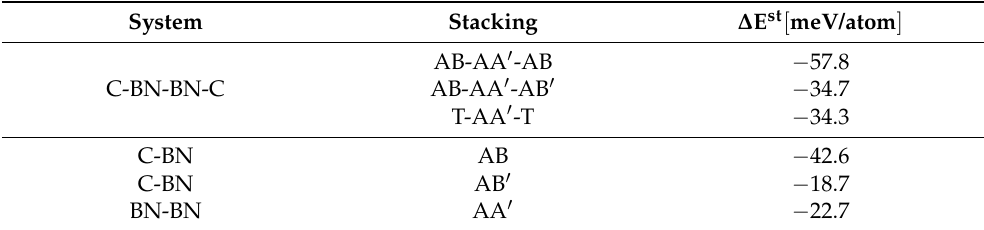
Table 1. Stacking energy ∆ E st calculated for quadrilayers and bilayers, obtained with PBE + vdW exchange correlation functional.